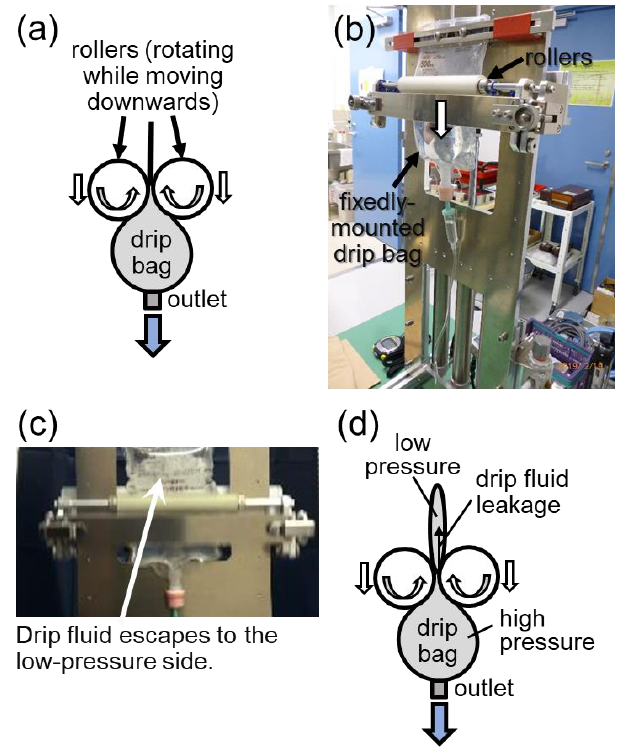
Figure 4. Prototype MOVE-ROLLER. ( a ) Squeezing mechanism on a drip bag by a pair of rollers. ( b ) Operational testing of the mechanism. ( c ) Observation of drip fluid escape. ( d ) Schematic explanation of the drip fluid leakage occurring inside the drip bag.